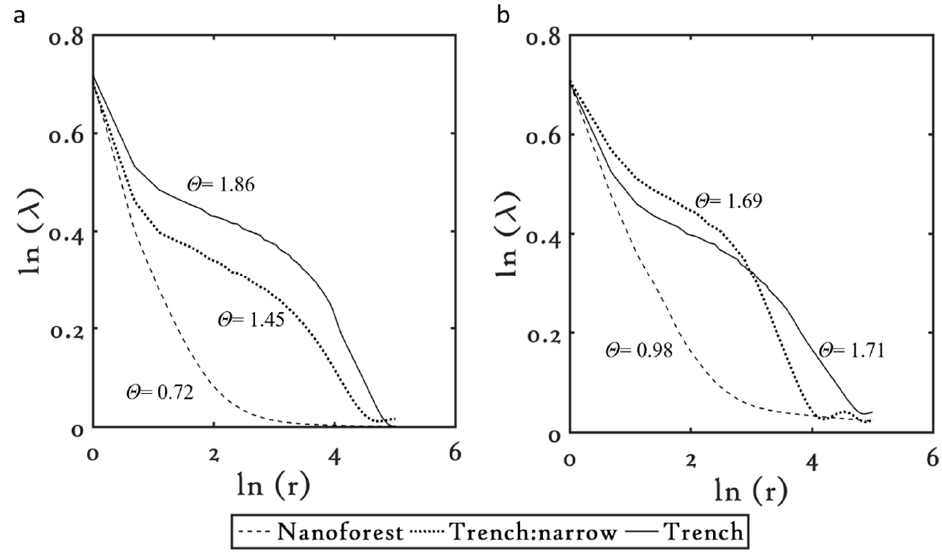
Figure 5. Lacunarity plots for the common microstructures on Cu at ( a ) 1 kHz and ( b ) 10